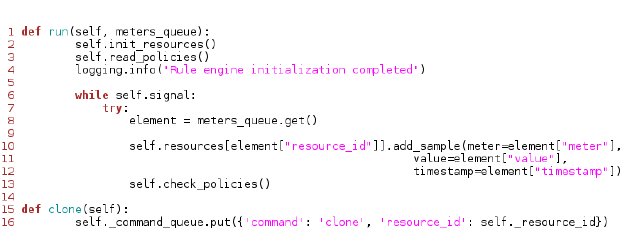
Figure 3: A Intellect rule